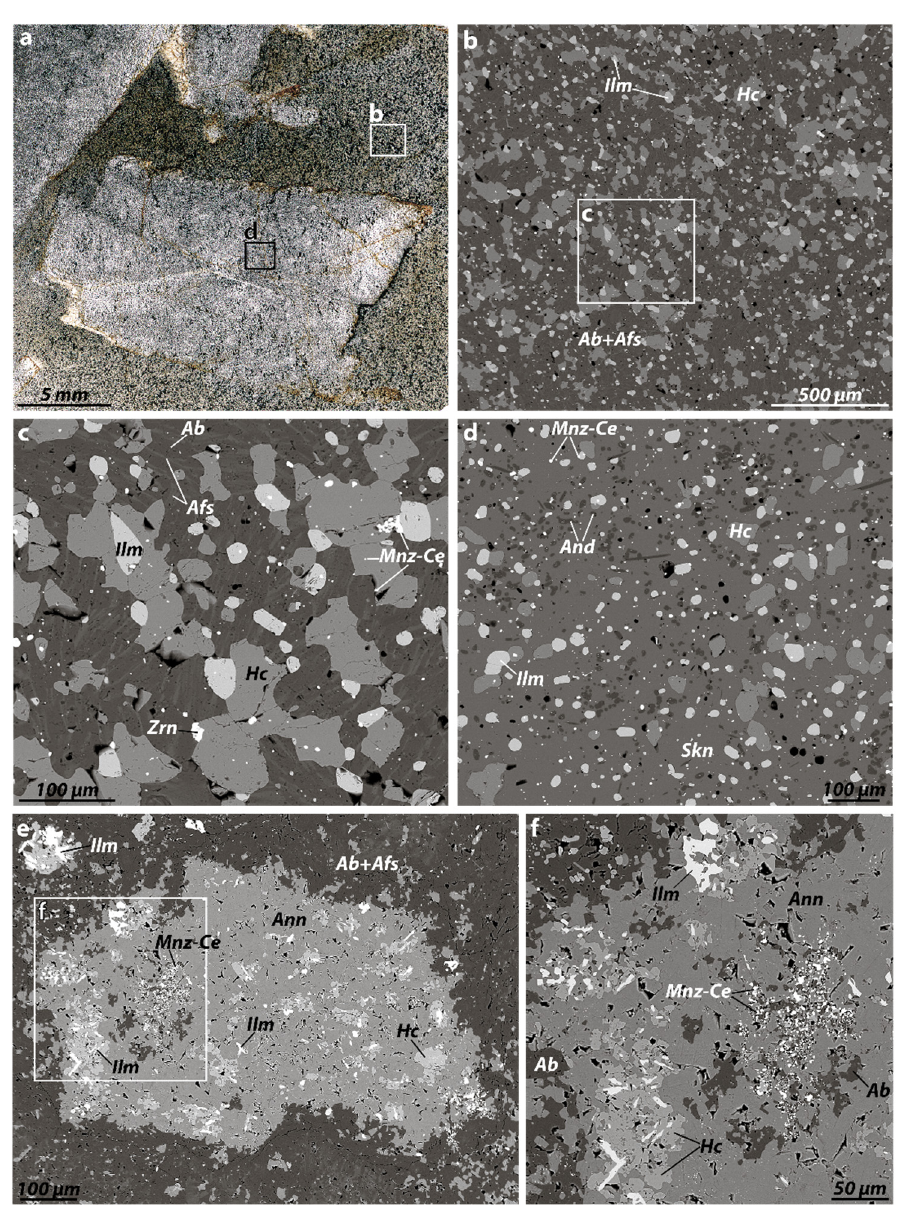
Figure 7. Mineral associations of aluminous hornfelses. ( a ) large poikilitic crystals of sekaninaite in a fine-grained mass of feldspars, annite, and hercynite (sample KCH-4); ( b ) detailed fragment of ( a ); ( c ) detailed fragment of ( b ); hercynite grains in association with feldspars, ilmenite, zircon, and monazite-(Ce); ( d ) fragment of the poikilitic crystal of sekaninaite with small inclusions of the hercynite, ilmenite, andalusite, and monazite-(Ce); ( e ) hercynite+ilmenite+annite segregation in hornfels (sample LV-119); ( f ) detailed fragment of ( e ). Photo of polish section in transmitted light ( a ) and BSE-images ( b – f ).